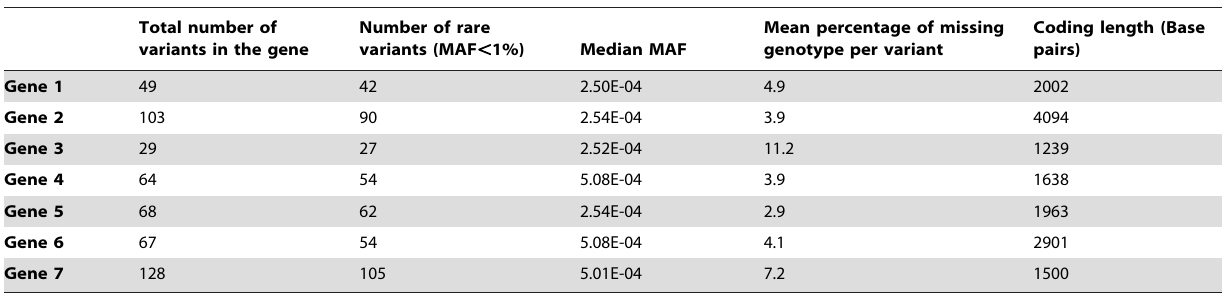
Table 2. Description of the seven genes.